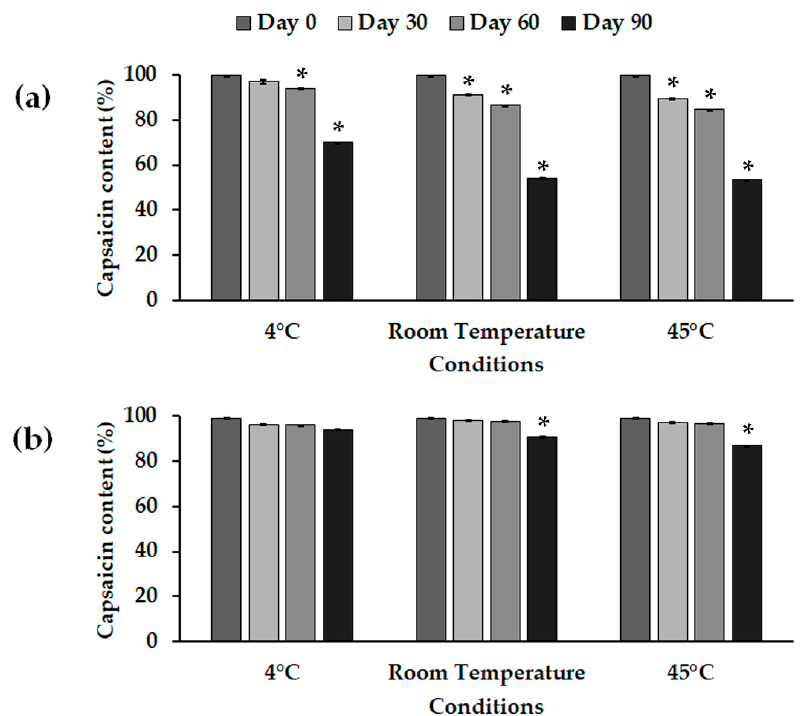
Figure 2. Percentages of capsaicin contents following 90 day storage of ( a ) chili-extract solution and ( b ) NLC_C, prepared by HSH with high shear intensity, at di ff erent conditions: 4 ◦ C, room temperature (RT), and 45 ◦ C. * The values are significantly di ff erent ( p < 0.05) compared to those for the initial formulation (Day